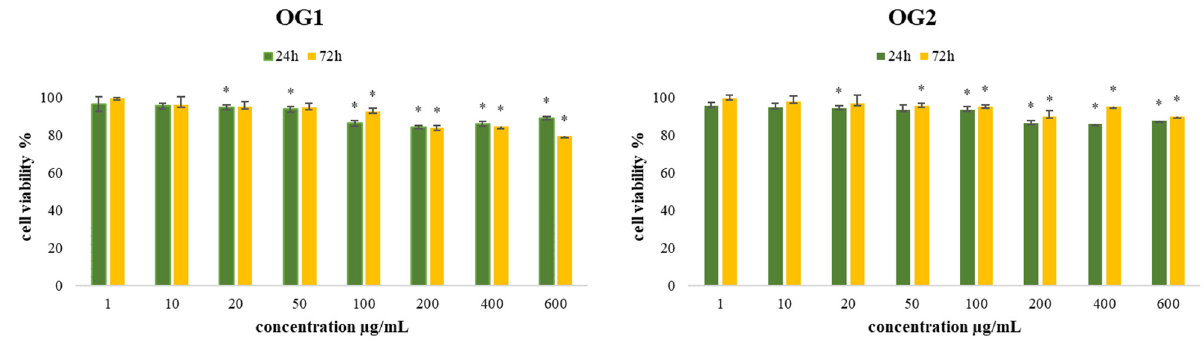
Figure 1. Effects of eight concentrations of OG1 and OG2 on MRC-5 cell viability after 24 h and 72 h of treatment. Results are presented as the mean of three independent experiments ± standard er- ror; * p < 0.05 relative to